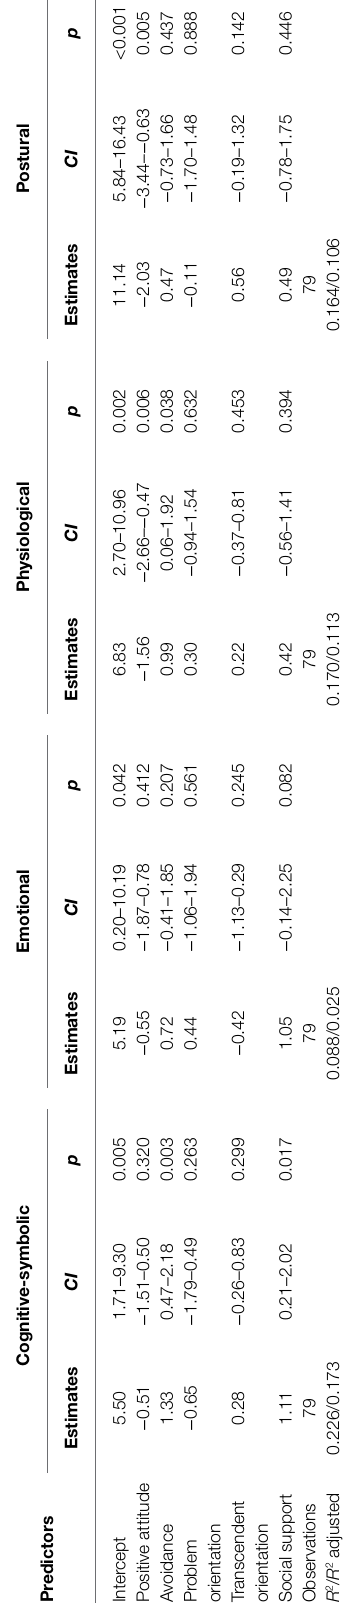
The scores on the FQ dimensions were indicated as dependent variable, while the coping strategies and having had psychotherapy or not ( − 1 no psychotherapy, 1 psychotherapy) were modeled as predictors. The independent variable and predictors were introduced in step 1, the interaction between psychotherapy and coping strategies in step 2. To avoid the multicollinearity,